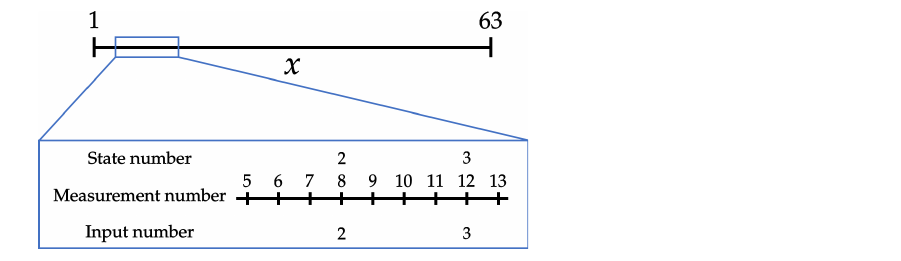
Figure 2. The location of the manipulating devices over the film width and the positions of the thickness